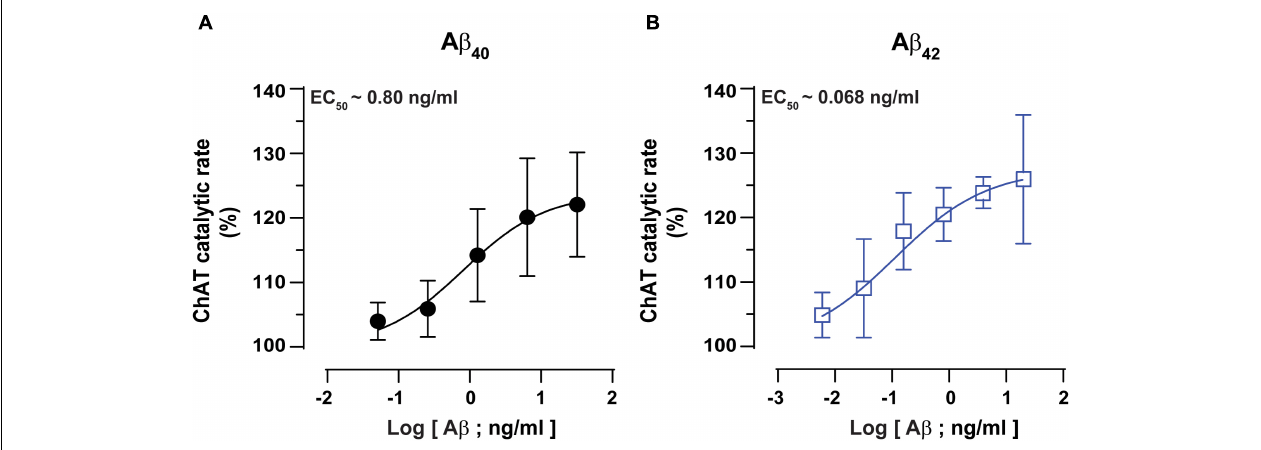
FIGURE 3 | ChAT enzyme kinetic analyses for the estimation of half-maximal effective (EC 50 ) concentration of A β 40 and A β 42. The curves in (A,B) represent the percent changes in the rate of ChAT ( (cid:49) RFU/h) at different A β 40 and A β 42 concentrations, ranging from 0 to 32 ng/mL and 0 to 20 ng/mL, respectively. The activity of control sample (ChAT with no A β ) was considered as 100%. The EC 50 values were calculated after fitting the curves using non-linear regression analysis in GraphPad Prism 7. The values are shown as mean ± SD of ≥ 3 independent